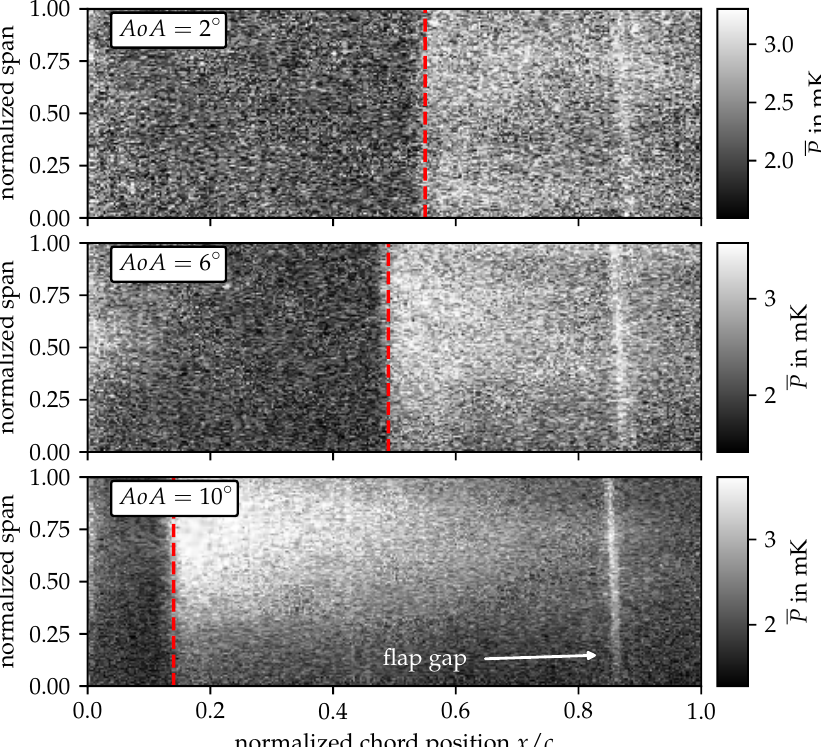
Figure 7. Comparison of the laminar-turbulent flow transition position (dashed lines) for variable angle of attack by means of the evaluation of thermographic image series with the harmonic signal processing approach. Experimental parameters: variable angle of attack, Re = 2 · 10 6